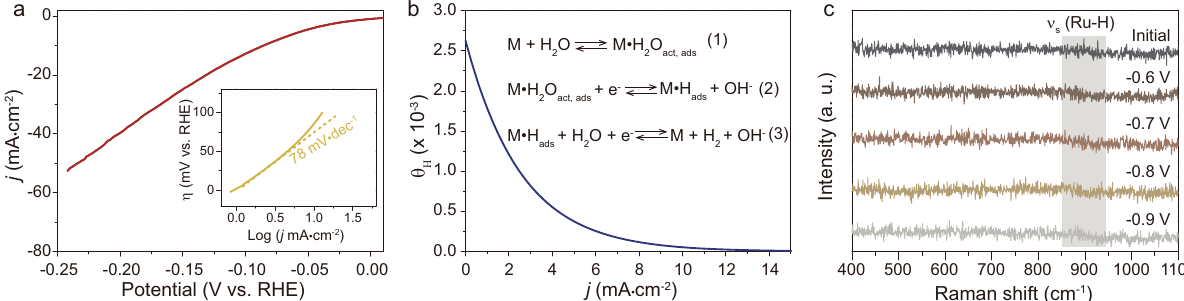
Fig. 1 | HER performance of commercial Ru/C (5 wt%) in 1.0M PBS. a LSV curve and the corresponding Tafel plot for commercial Ru/C (5.0 wt.%) loaded on CP. Scan rate: 2mV/s. b Hydrogen coverage as a function of current density obtained